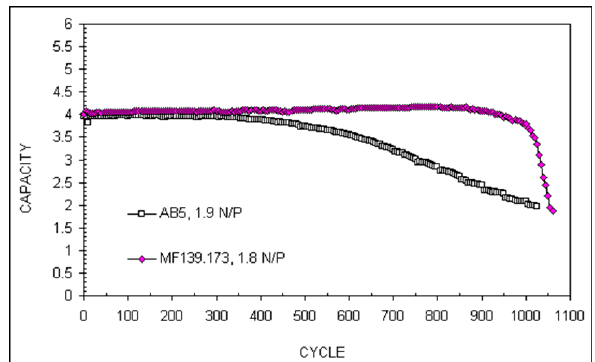
Figure 12. Comparison of cycle life in C-sized cell from AB 5 and AB 2 (MF139.173, Ti 12 Zr 21.5 V 10 Cr 8.5 Mn 13.6 Co 1.5 Ni 32.2 Sn 0.3 Al 0.4 ) alloys as negative electrode active materials. N/P denotes the ratio of capacities of negative and positive electrodes and capacity in the unit of Ah was obtained with a C/2 charge rate and a C/2 discharge rate to 0.9 V cell voltage.